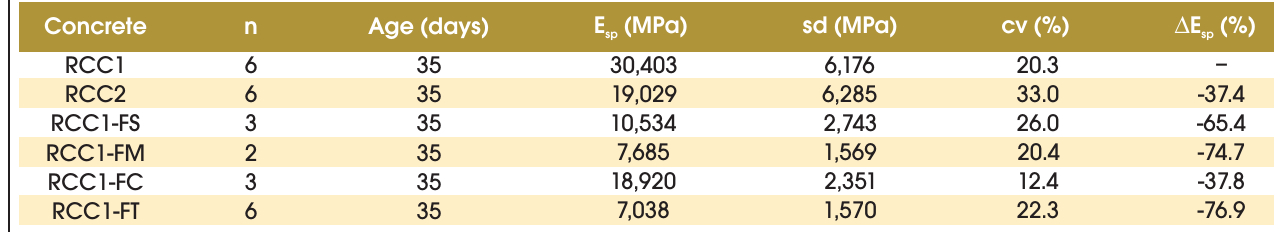
Table 7 – Modulus of elasticity of RCC in